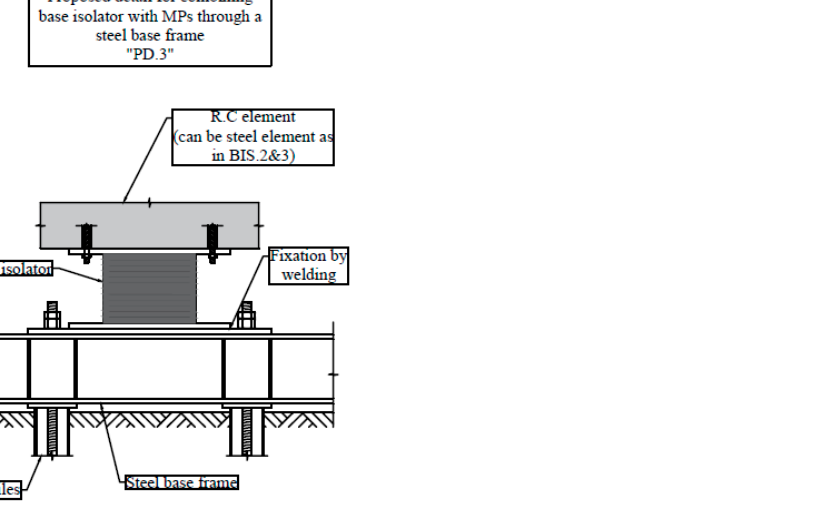
Figure 16. New proposed detail for combing MPs with BIS (new/existing steel base frame). In Table 3, a comparison between the three new proposed details is